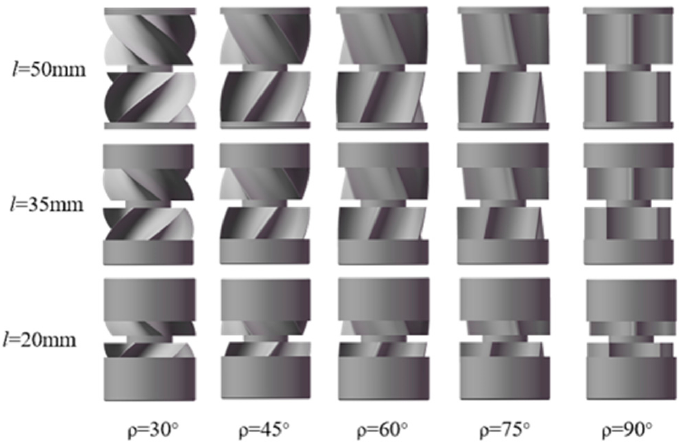
Figure 6. Three-dimensional model of feeding wheel with different parameters.